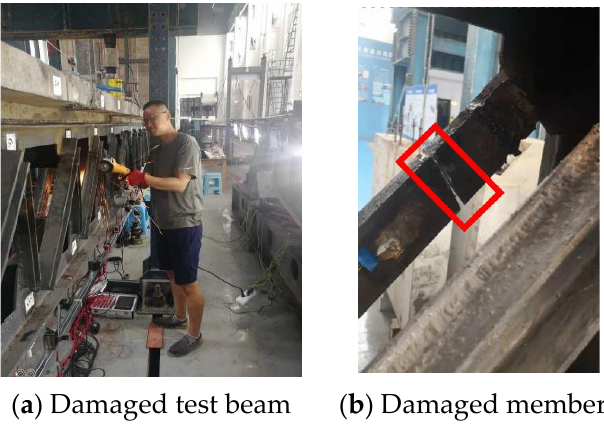
Figure 11. Photographs of damaged test beam and member.